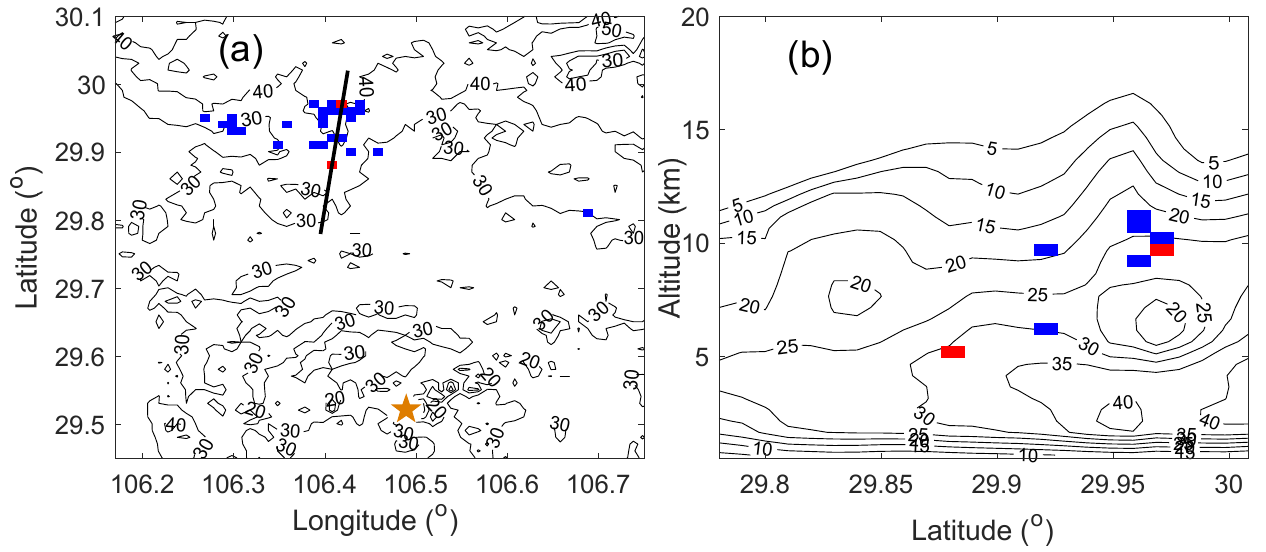
Figure 7. Distributions of the reflectivity and the LD, HD, and SD grids in ( a ) the horizontal and ( b ) the vertical at 19:02 CST. The contours in ( a , b ) indicate the distribution of ( a ) composite reflectivity and ( b ) reflectivity (unit: dBZ). The blue, green, and red rectangles represent the LD, HD, and SD grids, respectively. The yellow star in ( a ) indicates the location of the radar site. The black lines in ( a ) illustrate the positions of the vertical sections shown in ( b ).